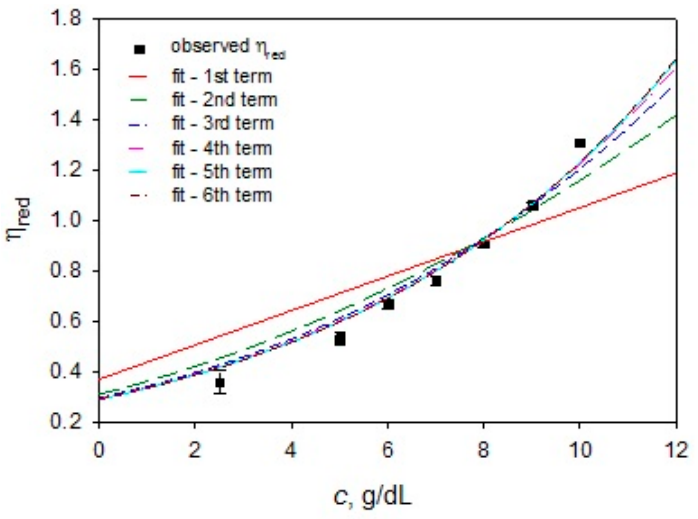
Figure 1. Huggin’s plot of reduced specific viscosity versus polymer concentration. Nonlinear regression by series expansion of Equation (7) and parameters converged by the sixth term for [ η ] = 0.292 ± 0.031 and K H = 0.500 ± 0.101 ( R 2 = 0.96). Lines for the first six term expansions of Equation (7) have been plotted. Vertical error bars are presented for all points.